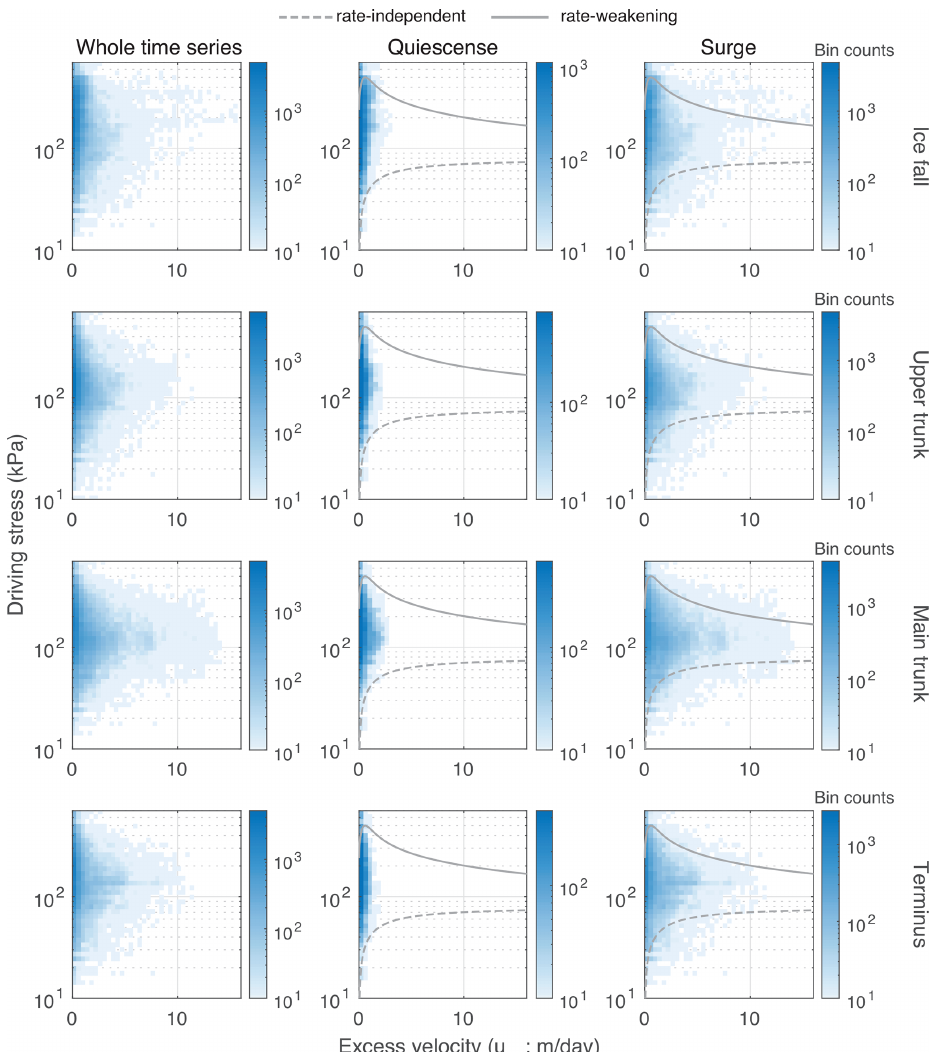
Figure 8. Relationship between driving stress and excess velocities, used as a proxy for sliding velocities. The data on each axis are separated in 40 bins, and the plot color represents the number of data points within a bin. Rate-independent and rate-weakening behaviors are shown by the dashed and full lines, respectively. Note that the y axis is logarithmic and the x axis is linear, and the effect of axes scaling on data visualization is shown in Figs. S4.8 and